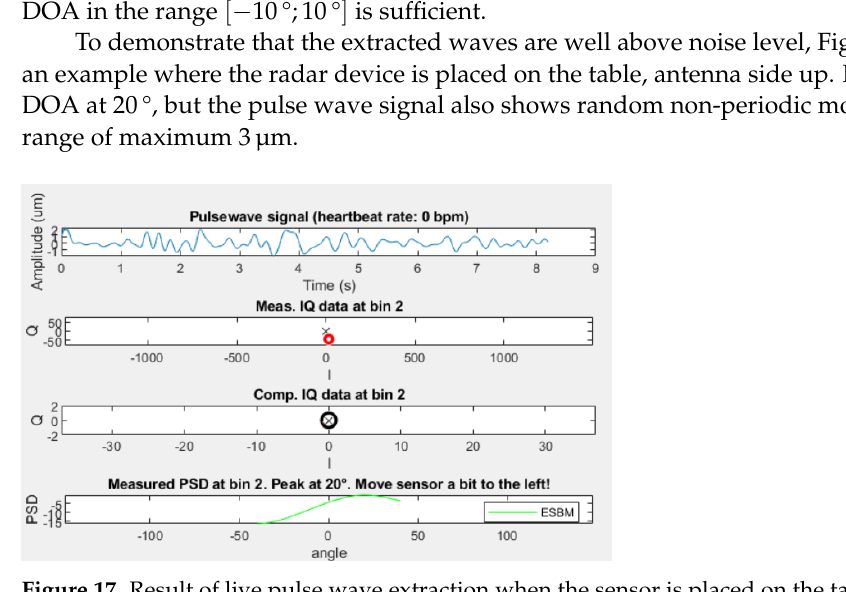
Figure 17. Result of live pulse wave extraction when the sensor is placed on the table and records only noise.